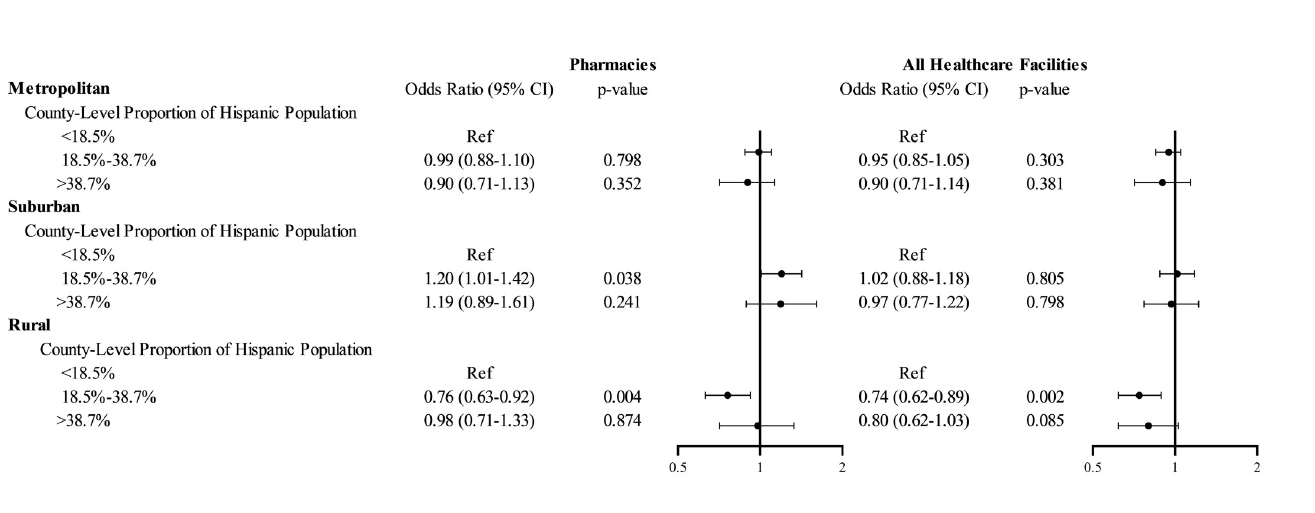
Fig 3. Adjusted odds ratios of facilities serving as COVID-19 vaccine administration locations, interaction for proportion Hispanic population and urbanicity. The figure shows the results of logistic regression models fitted with generalized estimating equations for the primary outcome of a healthcare facility (or a pharmacy) serving as a COVID-19 vaccine administration location. All healthcare facilities included pharmacies, FQHCs, RHCs, and HODs. The model adjusted for all covariates listed in Fig 1. Additionally, the model constructed for all healthcare facilities included an indicator variable for facility type (pharmacy vs. others). The circles represent the point estimate for the odds ratio, and the whiskers represent the 95% confidence interval. COVID-19, Coronavirus Disease 2019; FQHC, federally qualified health center; HOD, hospital outpatient department; RHC, rural health clinic.